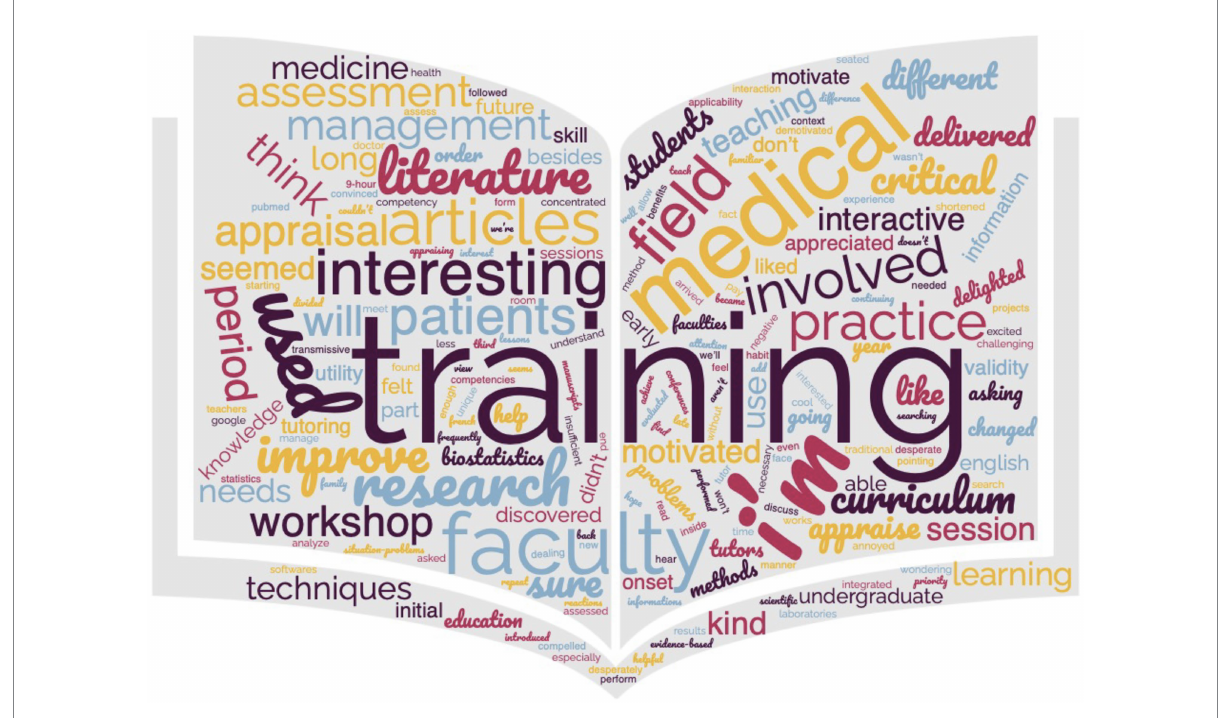
FIGURE 3 Word cloud of the 11